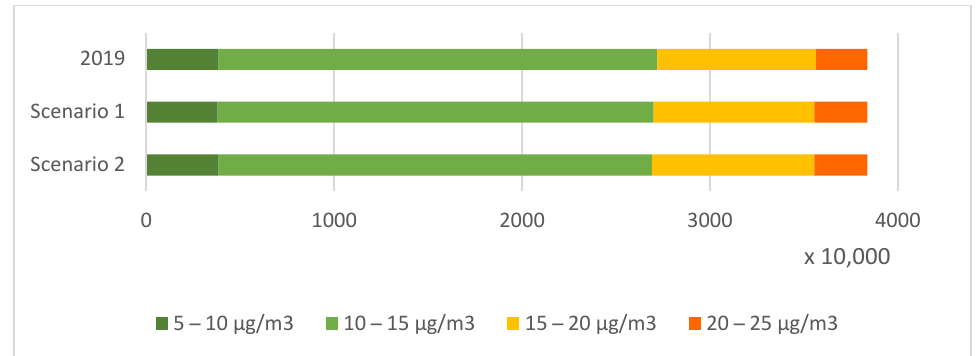
Figure 8. Population exposed to annual average concentrations of PM2.5 in Poland in 2019 and for scenario 1 and scenario 2.